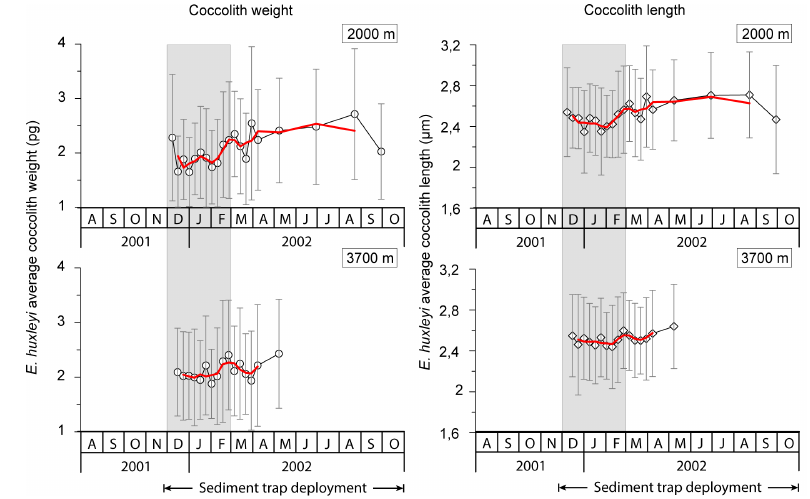
Figure 6. Mean and standard deviation of coccolith weight and length over the sediment trap deployment period at 2000 and 3700m at the 61 ◦ S site. The solid red line represents a three-point running average. Grey strips represent